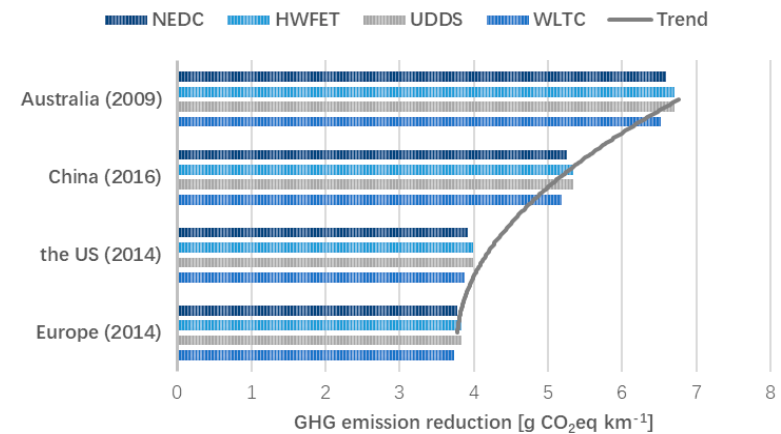
Figure 13. WTW GHG emission reduction from regenerative suspension under different country WTW GHG emission reduction from regenerative suspension under di ff erent contexts. country